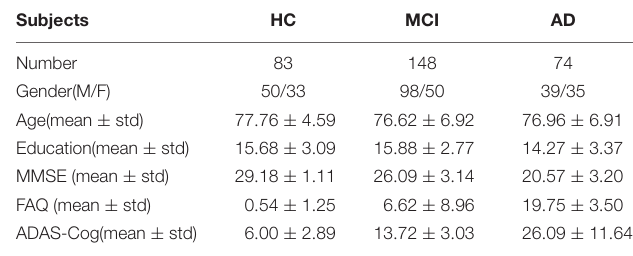
TABLE 1 | Characteristics of the